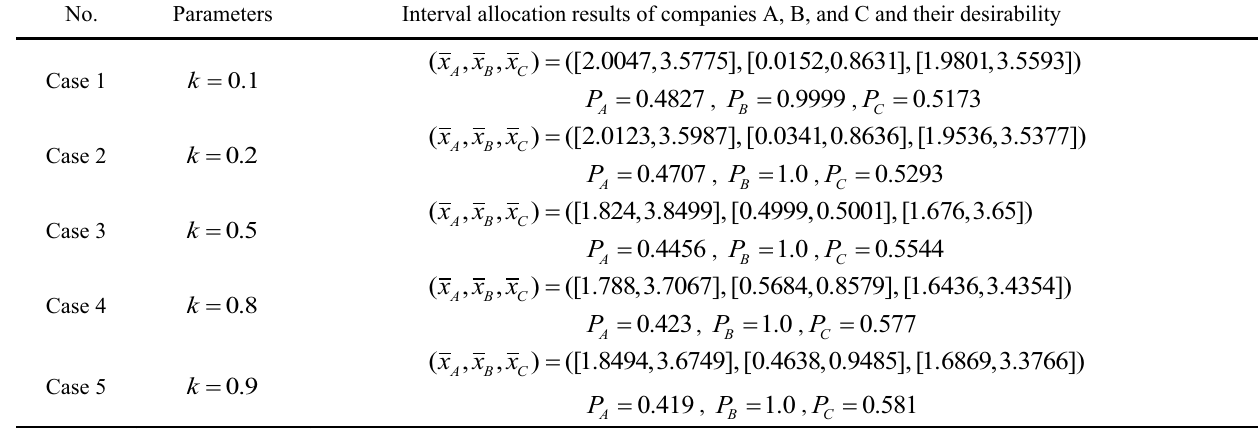
Table 2 Relatively optimal interval core based on desirability function No. Parameters Interval allocation results of companies A, B, and C and their desirability